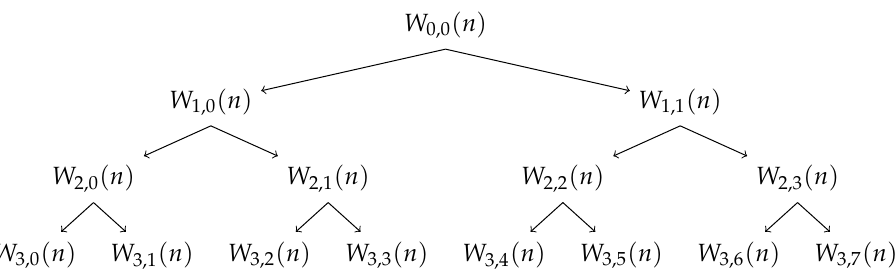
Figure 3. Wavelet Packet Tree - Example of decomposition until scale level